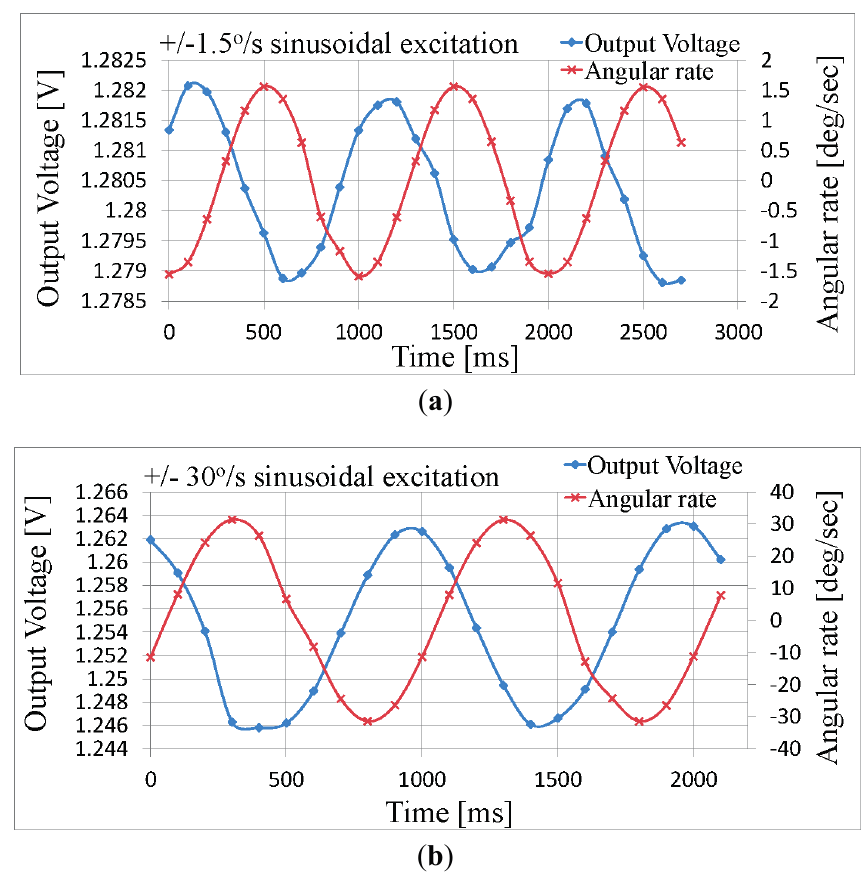
Figure 9. Measured results of the output voltage vs . angular rate. ( a ) Angular rates between 0 °/s and a maximum of ±1.5 °/s (sinusoidally modulated); and ( b ) Angular rates up to ±30 °/s (sinusoidally